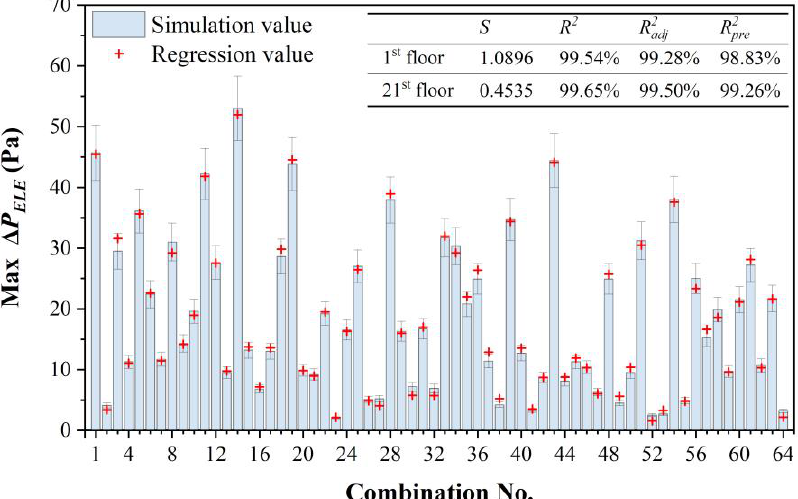
Figure 13. The maximum pressure difference at elevator doors: the contrast of simulation and re- gression values.